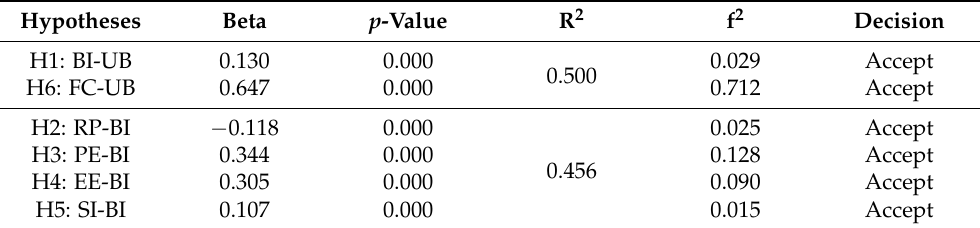
Table 4. Path coefficient.